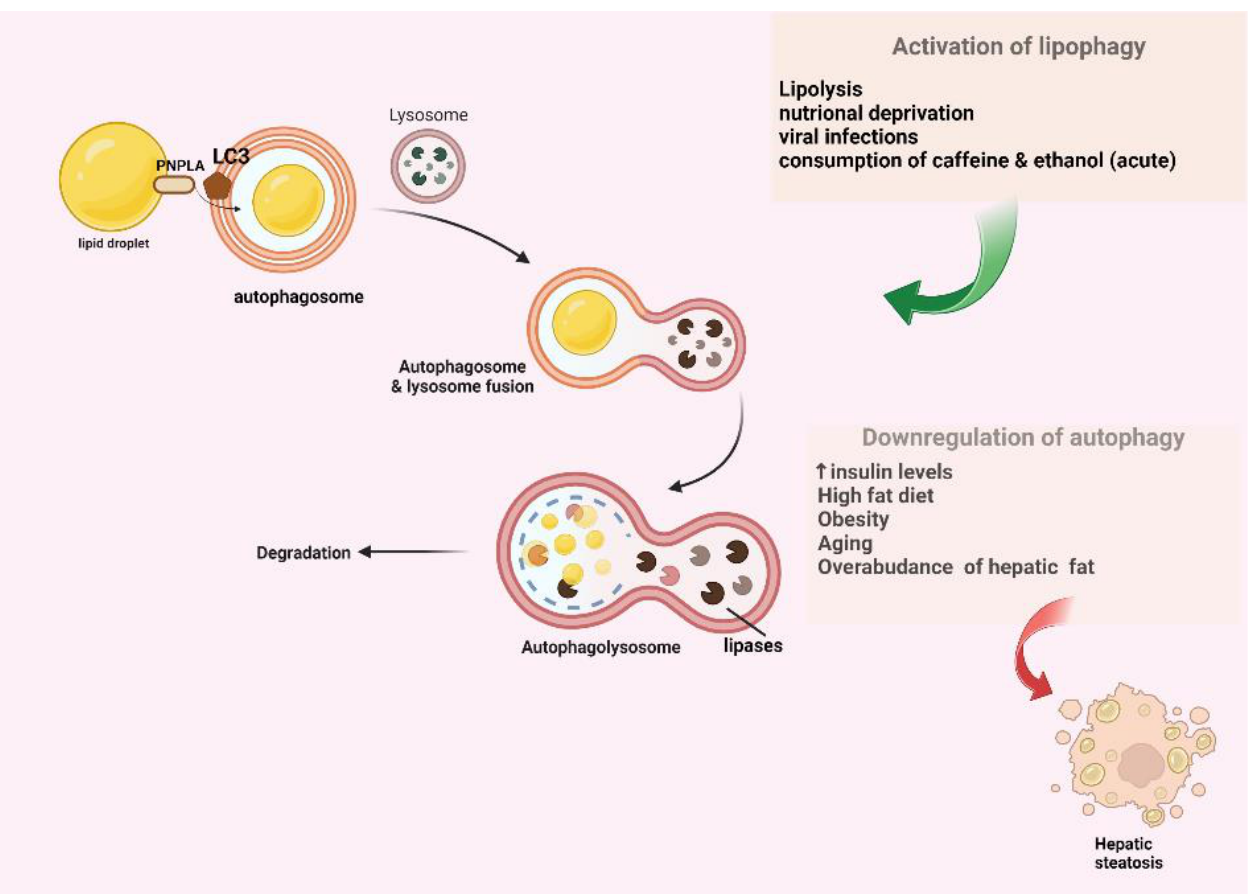
Figure 2. A schematic presentation of lipophagy. Autophagy pathway is closely related to NAFLD. Autophagy is downregulated in circumstances that favor NASH, such as increased insulin levels, obesity, increased consumption of lipids, as well as aging and overabundance of lipid storage in the liver parenchyma. The LDS are recognized and engulfed into autophagosomes via the interaction between LC3 and PNPLA. Then, fusion occurs between autophagosome and lysosome, resulting in autophagolysosome, which subsequently leads to the degradation of LDs by lipases. This figure was created with “BioRender.com” , accessed on 29 September 2022. (Agreement number